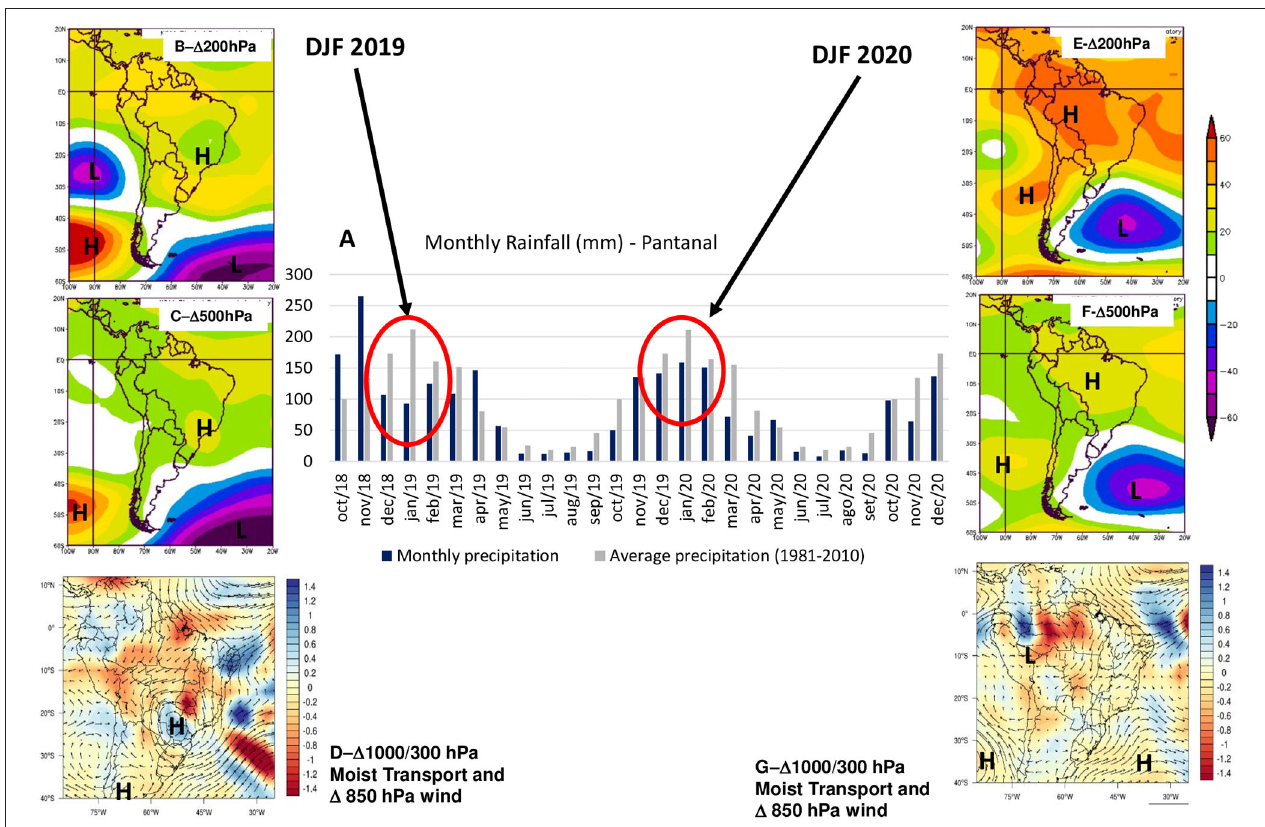
FIGURE 6 | (A) Mean monthly precipitation from October 2018 to September 2020 for the Brazilian Pantanal. Blue bars show observed precipitation and gray bars show 1981–2010 climatology. (B,E) show 200, (C,F) 500 geopotential height anomalies, (D,G) 1,000–300 hPa vertically integrated moisture transport (color) and 850 hPa winds (arrows) for December-February 2019 (left) and 2020 (right). Base period is